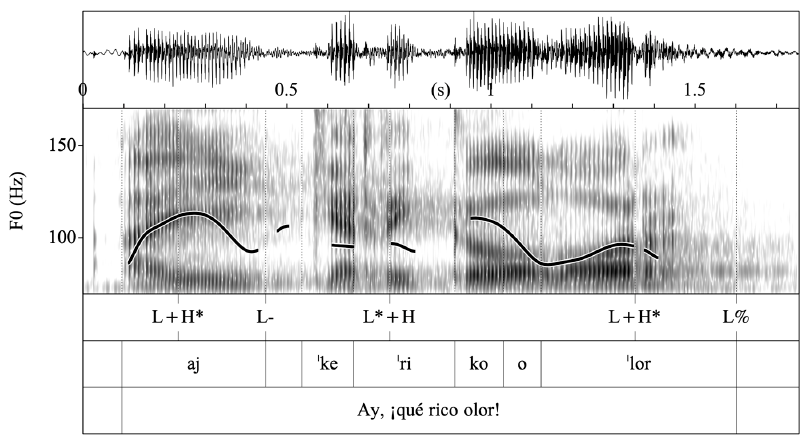
Figure 18. Waveform, spectrogram and F0 trace of the what -exclamative Ciao, Roberto! Che sorpresa! in L2 Italian (F34, level B2) produced with the target-like L+H*+L L% pattern. The second pair offers the same sentences in L2 Spanish, realized with L+H* in the nuclear position in both cases; the latter one was produced with an upstep (¡) (Figures 19 and 20).